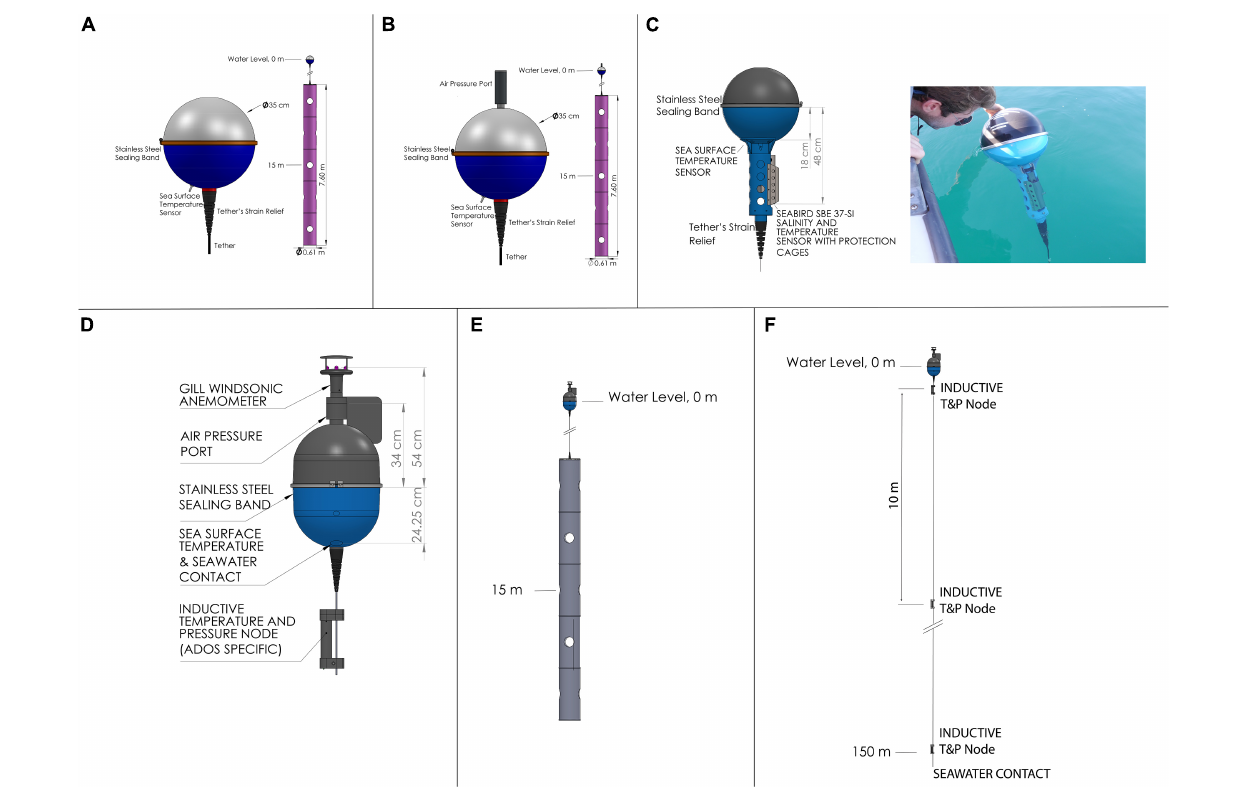
FIGURE 3 | (A) Schematic of the LDL SVP drifter (SST, 15-m depth currents). (B) Schematic of the LDL SVP-B drifter (SST, SLP, 15-m depth currents). (C) Schematic and picture of the LDL SVP-S drifter (SST, SSS, SLP optional, 15-m depth currents). (D) Schematic of the surface buoy (horizontal wind, SLP, SST) used for the LDL Minimet and ADOS drifters. (E) Schematic of the Minimet drifter (SST, SLP, horizontal wind, and 15-m depth currents). (F) Schematic of the ADOS drifter (SST, SLP, horizontal wind, subsurface temperature and pressure, up to 200 m with 10-m resolution). The ADOS can also be configured with ADCPs and conductivity sensors. All sensors use inductive communication modules to relay the data in real time through the Iridium satellite system.